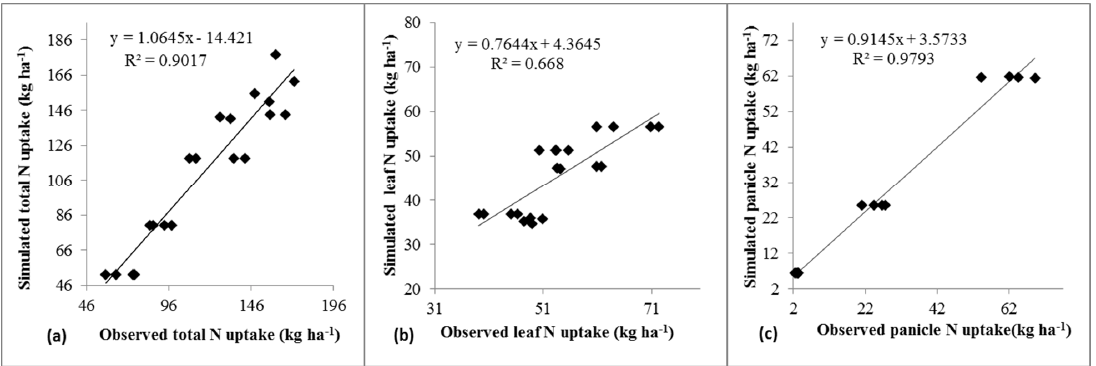
Figure 3. Simulated vs. observed total N uptake, leaf N uptake and panicle N uptake, (a, b, c) for 2007 calibration period, in Kunshan, Nanjing, China.